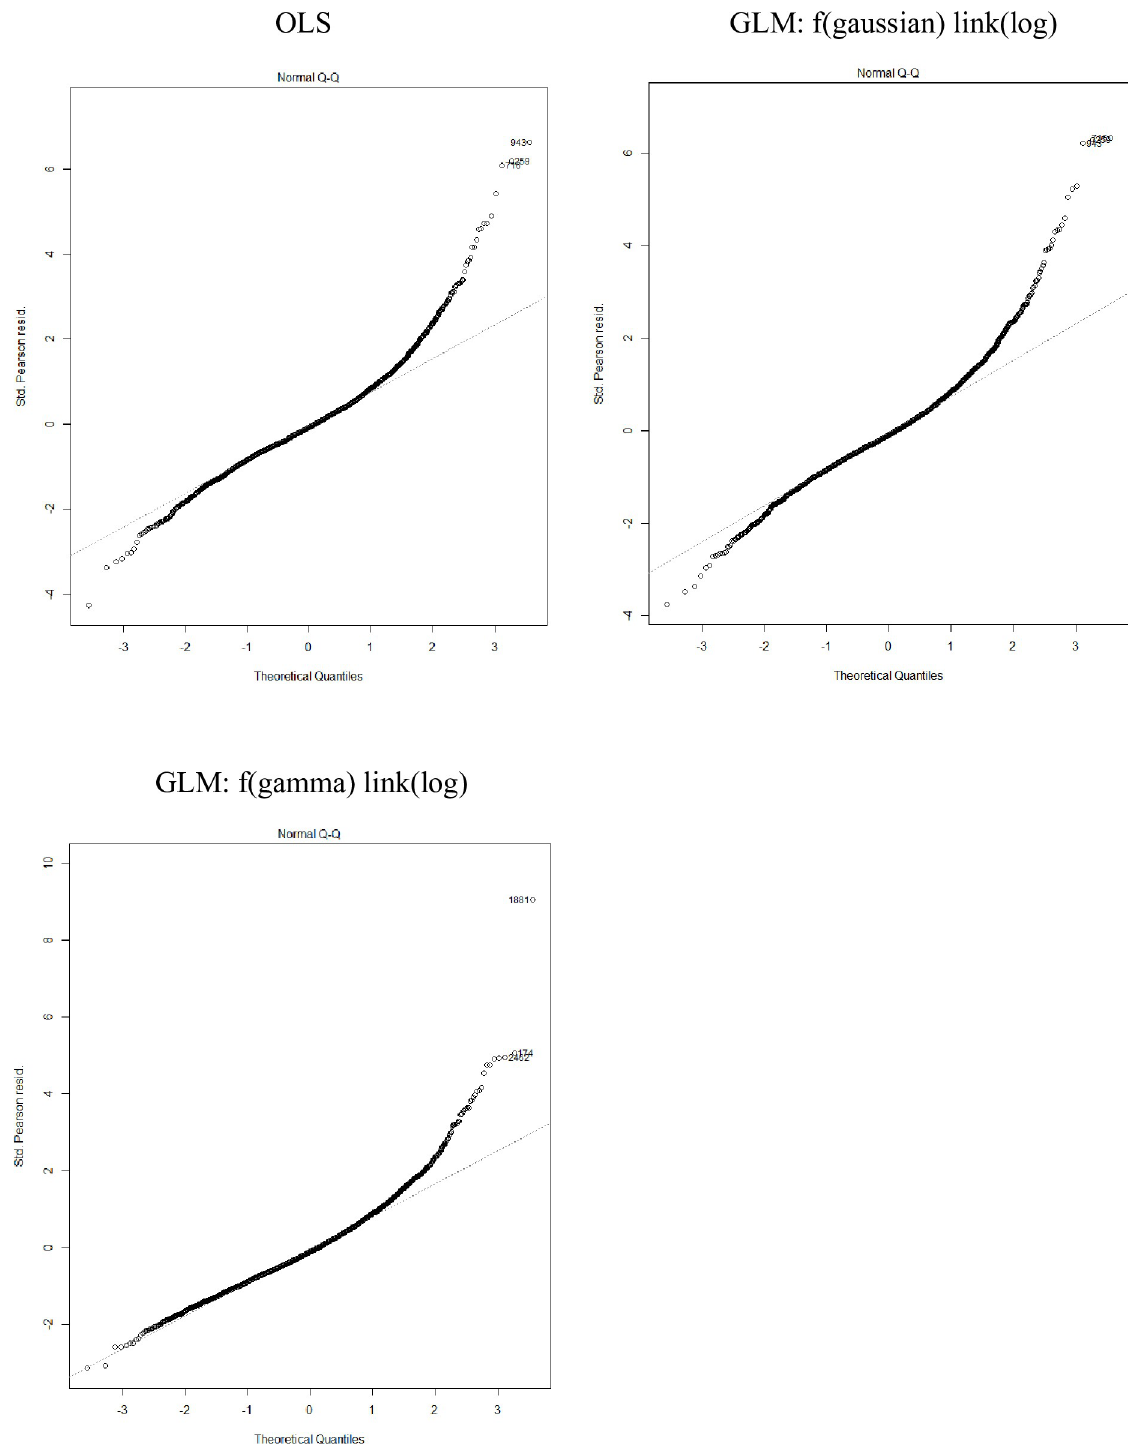
Fig 5. Q-Q plots for standardized deviance residuals for Hawaii longline fishery trip cost models.